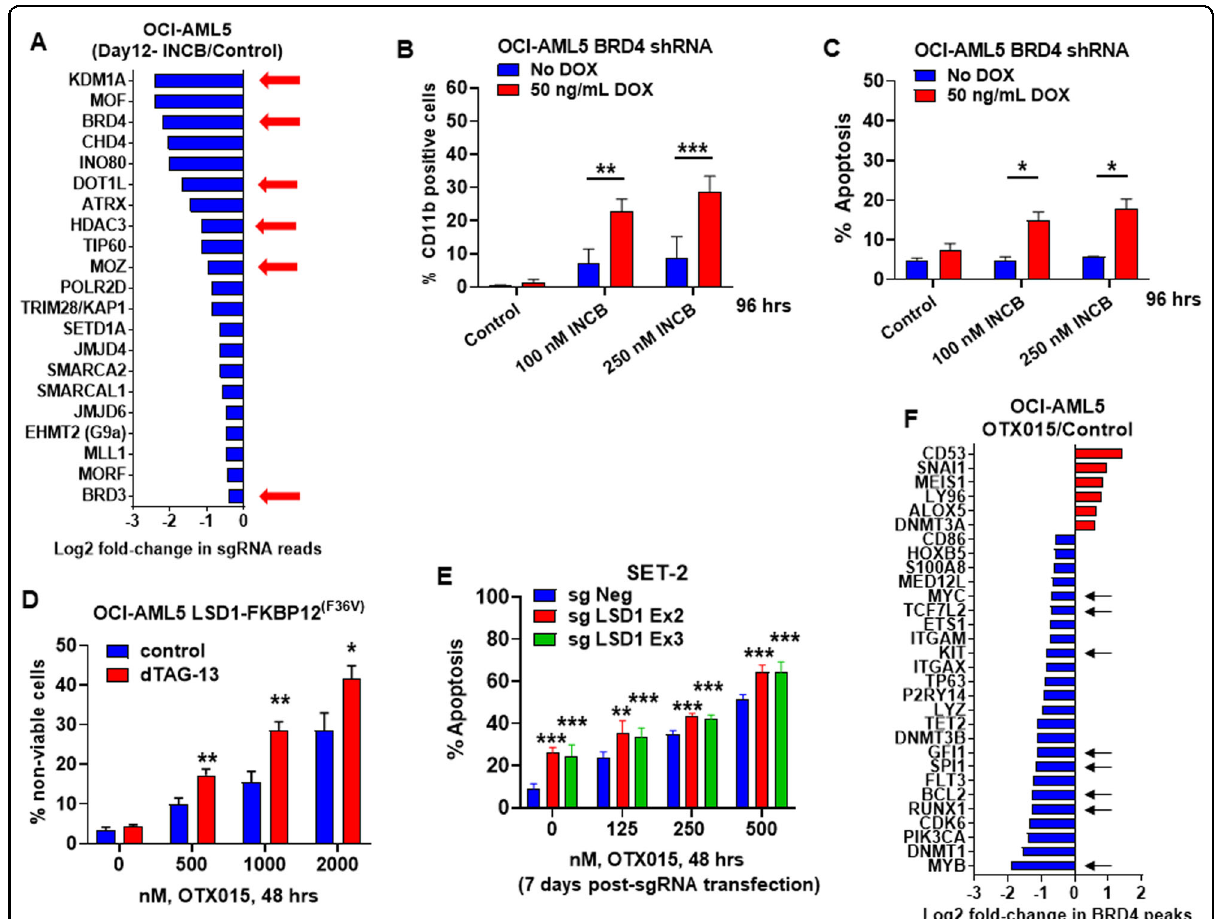
Fig. 4 Synthetic lethal activity of treatment with INCB059872 and a CRISPR-Cas9-mediated domain-focused epigenetically targeted sgRNA library in AML cells. A OCI-AML5 Cas9 cells were transduced with a library of domain-speci fi c sgRNAs against chromatin modifying proteins and incubated for 8 days. Then, 250 nM of INCB059872 was added and the cells were incubated for an additional 96 h. Live cells were harvested; genomic DNA was isolated and minimally ampli fi ed with primers fl anking the sgRNA sequences. Sequencing libraries were generated and amplicon-seq was performed. The graph shows log2 fold-changes in selected sgRNAs which dropped out more due to treatment with INCB059872 than control cells at day 12 post-transduction. B OCI-AML5 cells with stable expression of DOX-inducible BRD4 shRNA were induced with DOX and treated with the indicated concentrations of INCB059872 for 96 h. Following this, the % of CD11b cells was determined by fl ow cytometry. Mean of two independent experiments + S.D. ** p < 0.01, *** p < 0.005 as determined by a two-tailed, unpaired t -test. C OCI-AML5 cells with stable expression of DOX-inducible BRD4 shRNA were induced with DOX and then treated with the indicated concentrations of INCB059872 for 96 h. Following this, the % of annexin V- positive, apoptotic cells were determined by fl ow cytometry. Mean of two independent experiments + S.D. * p < 0.05 as determined by a two-tailed, unpaired t -test. D OCI-AML5 LSD1-FKBP12 (F36V) cells were treated with the indicated concentrations of OTX015 with and without 500 nM of dTAG-13 for 48 h. Then, the % of To-Pro-3 iodide positive cells were determined by fl ow cytometry. Mean of three experiments + S. E. M. * p < 0.05, ** p < 0.01 compared to cells with no dTAG-13 treatment (determined by a two-tailed, unpaired t -test). E SET-2 cells were transfected with sgNeg or LSD1 sgRNAs and incubated for 5 days. Then, cells were treated with the indicated concentrations of OTX015 for 48 h and the % of apoptotic cells was determined by fl ow cytometry. Mean of two independent experiments performed in duplicate + S.D. ** p < 0.01, *** p < 0.005 relative to sgNeg- transfected cells (determined by a two-tailed, unpaired t -test). F Log2 fold-changes in BRD4 peaks (determined by DiffReps analysis of BRD4 ChIP-Seq data) on LSD1 target genes and selected AML-relevant genes in OCI-AML5 cells treated with 1000 nM of OTX015 for 8